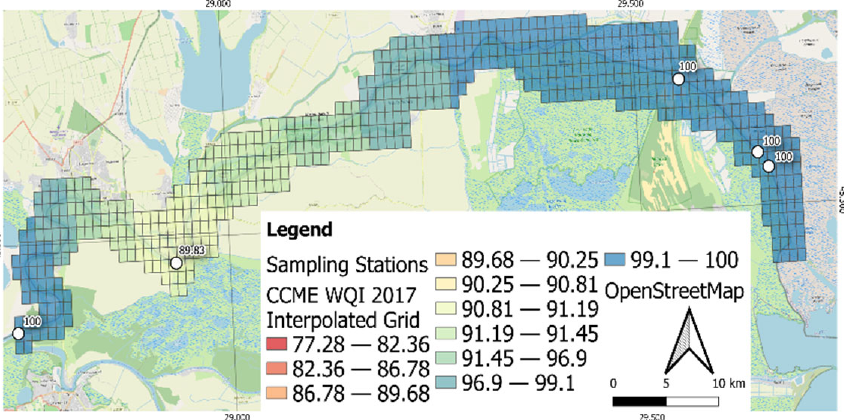
Figure 7. CCME WQI trends in 2016 on the Chilia branch.